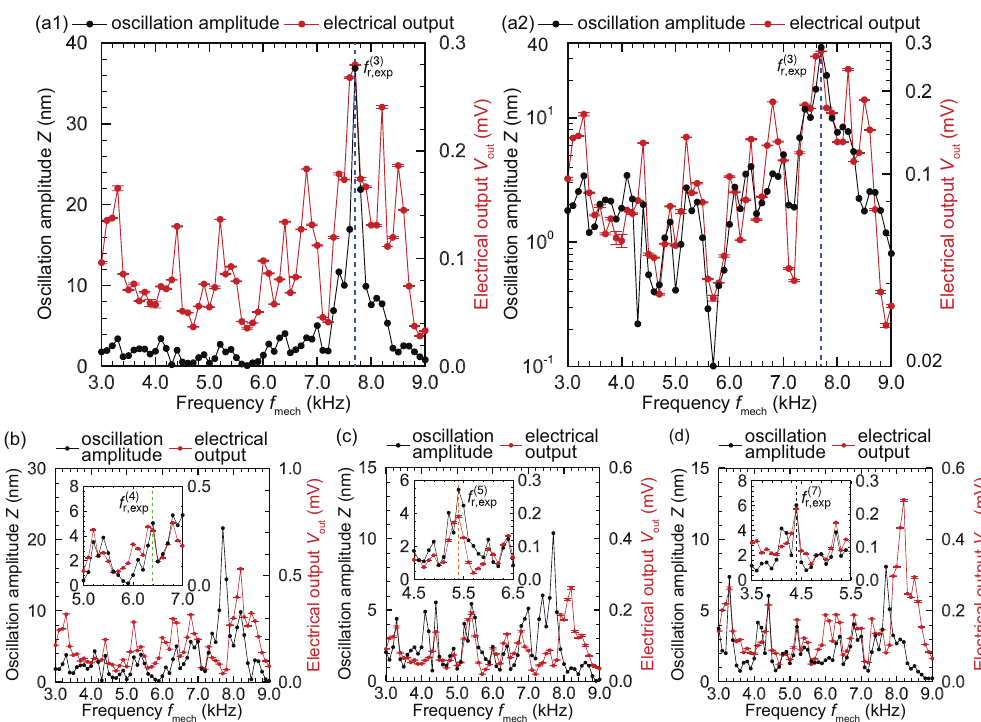
Figure 6. Frequency characteristics of the oscillation amplitude and the electrical output for electrodes ( a ) 3, ( b ) 4, ( c ) 5, and ( d ) 7, when the device was oscillated by the actuator. In the panel (a2), the oscillation amplitude and the electrical output are plotted in log scale. In the case of electrode 3, ( 3 ) Z and V out were maximized at f r,exp , and the resonance frequency could be determined by measuring V out . The insets in (b)–(d) show magnified views near the corresponding resonance frequencies ( n ) f r,exp ( n = 4, 5, 7). At the resonance frequency, peaks are present in both the oscillation amplitude and the electrical output, and the electrical output is generated by the strain produced at resonance. The frequency selectivity is shown by both the oscillation amplitude and the electrical output and the time for the determination of the resonance position can be reduced by measuring the electrical output.